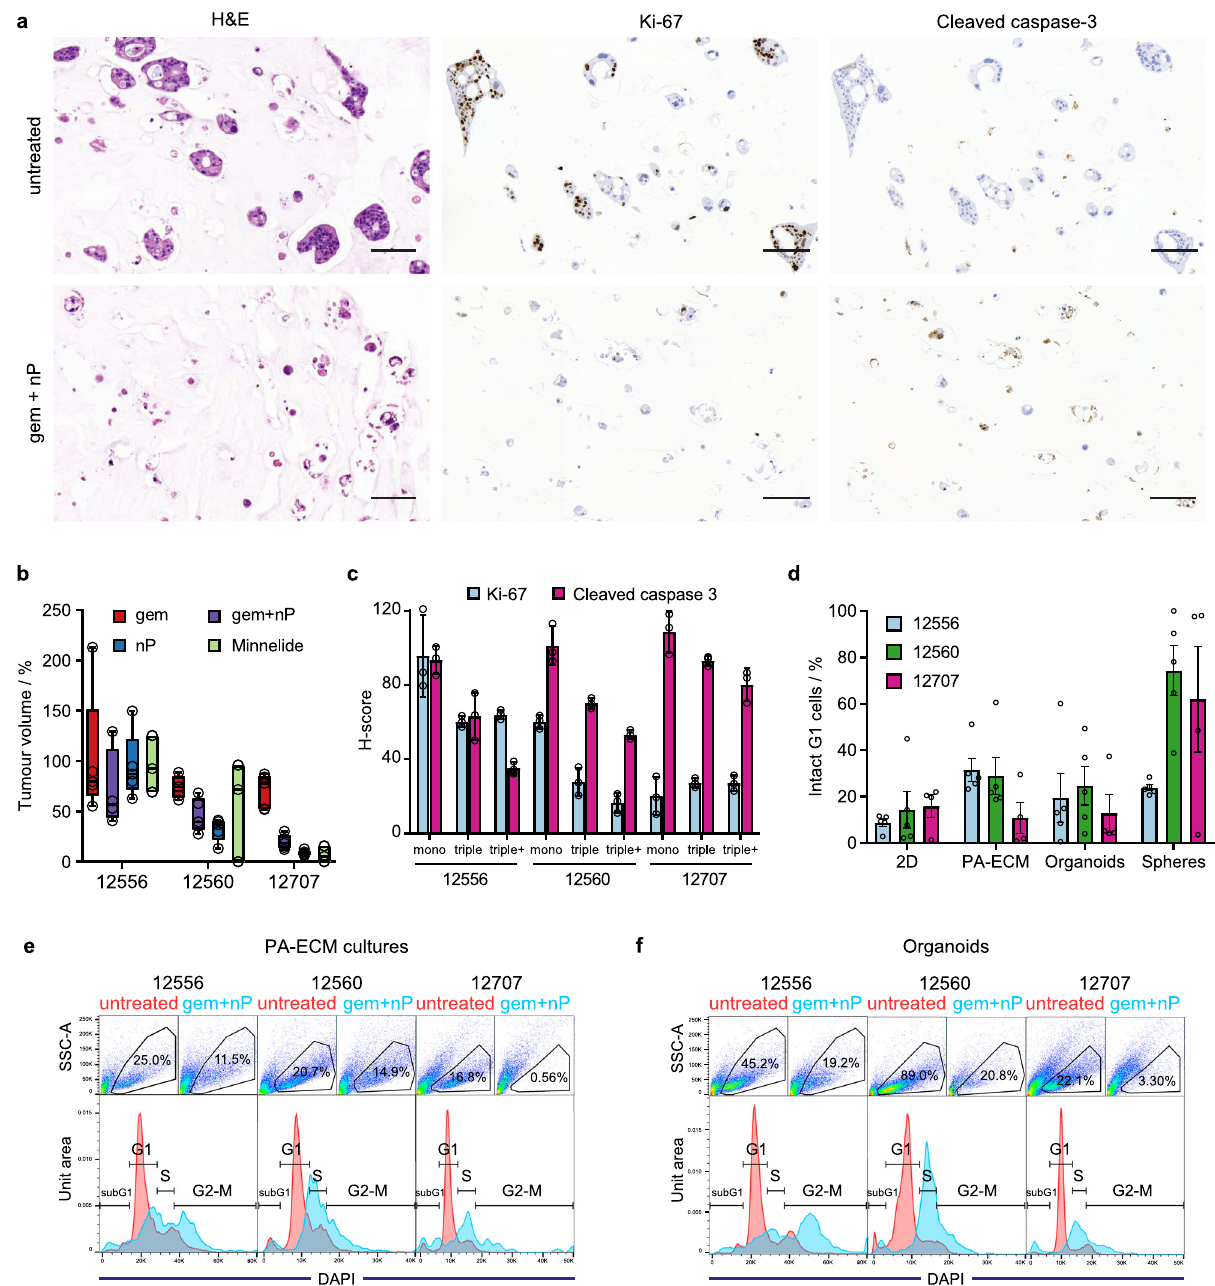
Fig. 8 PDAC treatment response in PA-ECM and organoid cultures. a Histology of PDAC (12560) mono- and triple cultures in PA-ECM treated with gemcitabine/nab-paclitaxel. Cells were stained with H&E to assess cellularity, Ki-67 for proliferation and cleaved caspase-3 for apoptosis. Scale bars: 100 µ m. b In vivo response of PDX tumours to chemotherapy depicted as percentage of tumour volume post-treatment relative to controls (0.9% NaCl). Box plots indicate range, interquartile range and median. For each patient and condition, n = 5 mice with one tumour each. c Quanti fi cation of Ki-67 and cleaved caspase-3 staining of PDAC mono- and triple cultures in PA-ECM treated with gemcitabine/nab-paclitaxel. Triple + cultures contained twice the number of PSCs (mean ± SD; n = 3 biological replicates). d Response of PA-ECM and organoid cultures to gemcitabine/nab-paclitaxel as assayed by fl ow cytometry. Percentages represent the proportion of cells that were both intact and in G1 phase compared to untreated controls (mean ± SD; n = 5 biological replicates). e , f Flow cytometry plots showing the cell cycle arrest of PA-ECM ( e ) and organoid ( f ) cultures treated with gemcitabine/nab-paclitaxel. The upper panels show the gated populations of intact cells. The lower panels depict the cell cycle pro fi les of untreated (red) and treated (blue) samples gated to exclude debris and